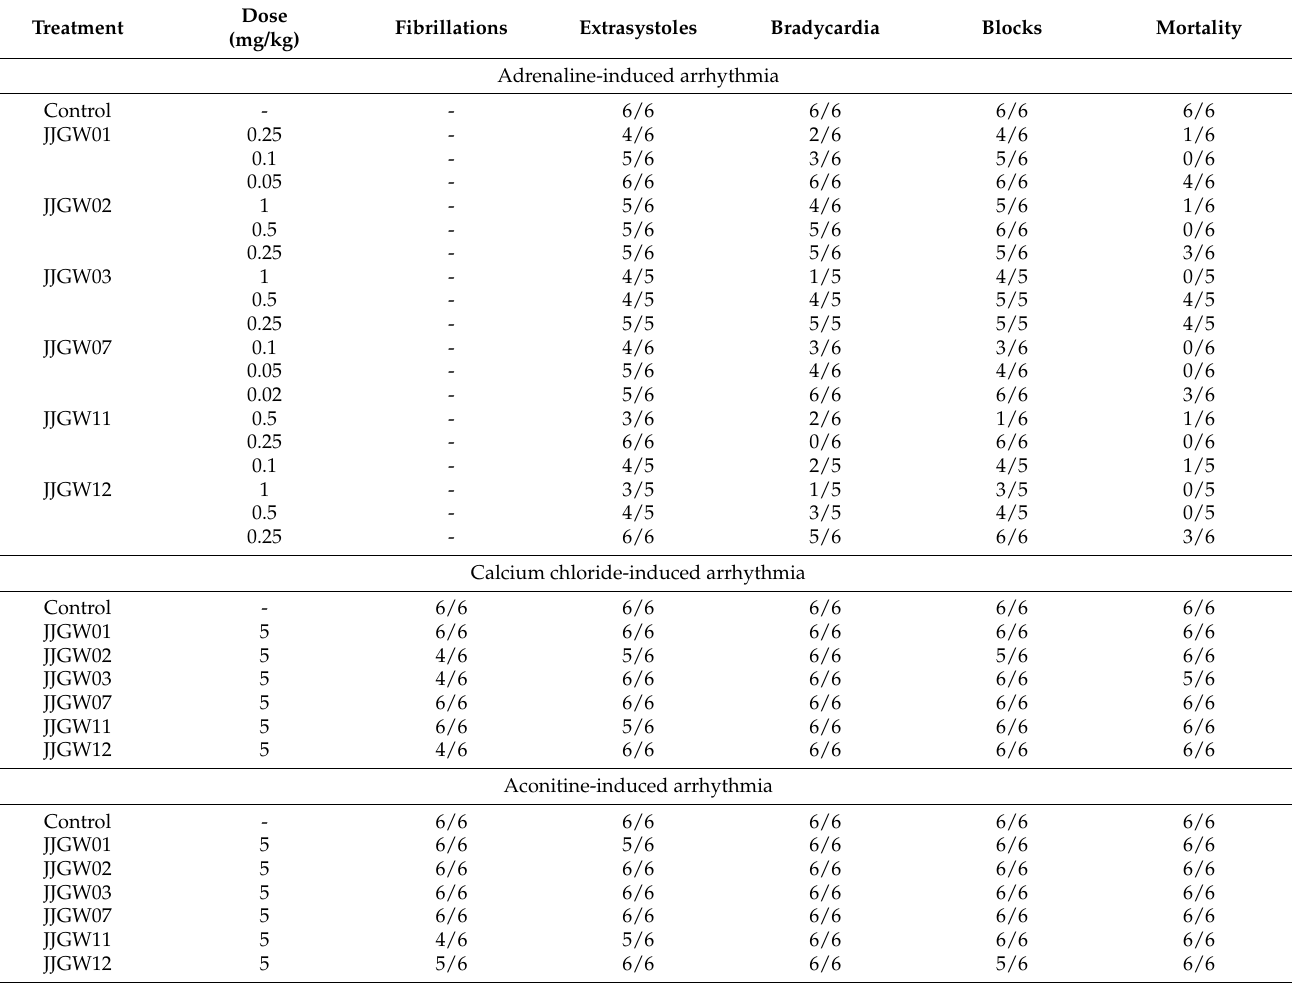
Table 2. The effect of arylpiperazine derivatives on the cardiac events occurrence in adrenaline-, calcium chloride-, and aconitine-induced arrhythmia models in rats.